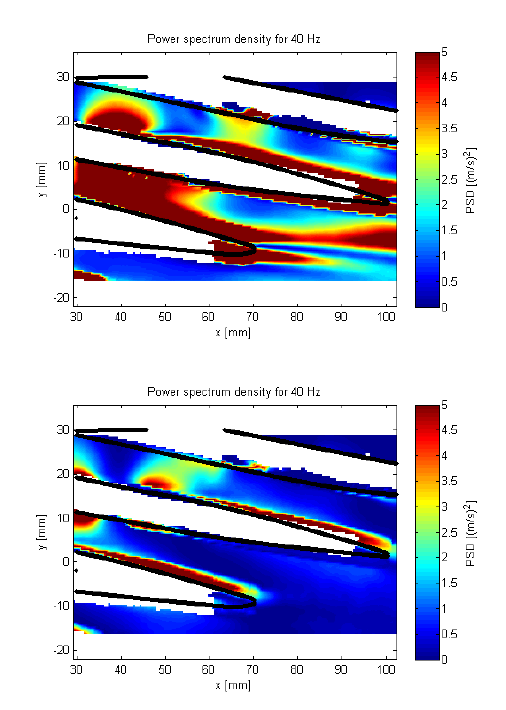
Fig. 8a, b. PSD value distribution for 40 Hz for both vel. components for compressor cascade, excited at φ = 180° .